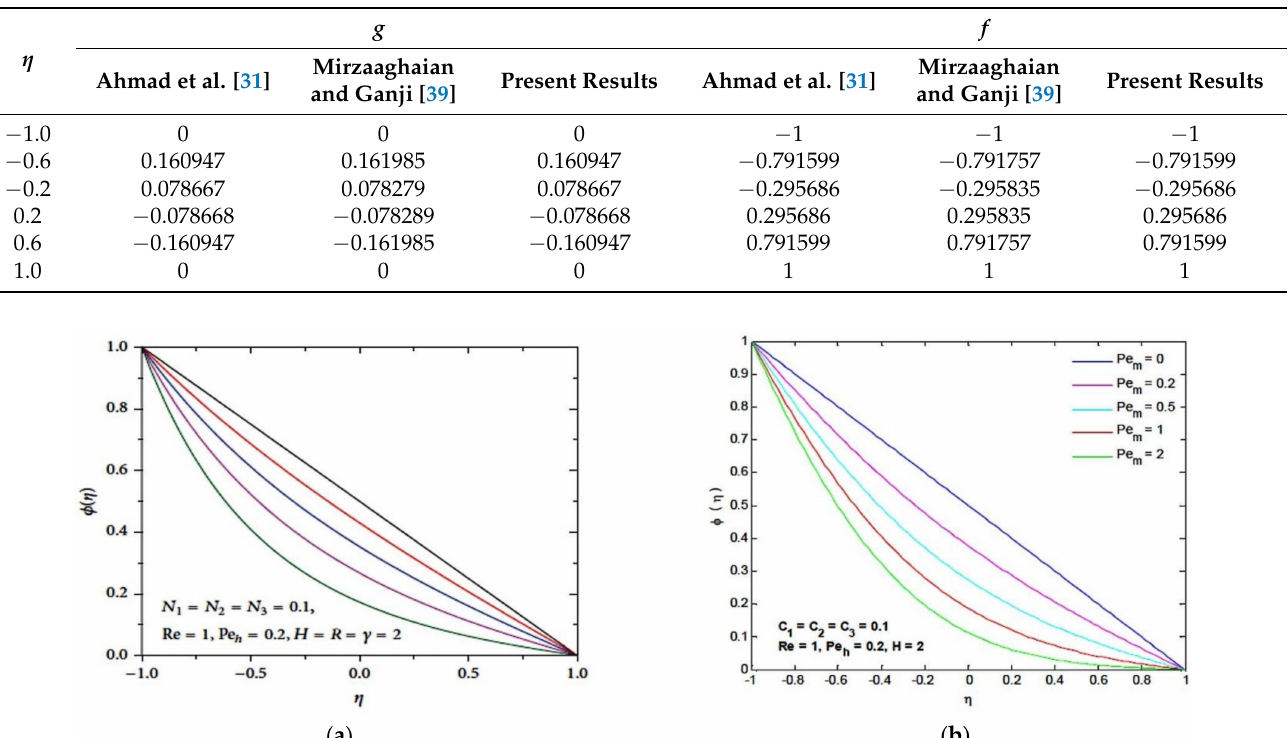
Table 1. Comparison of microrotation g and velocity f against different values of η when Pe m =